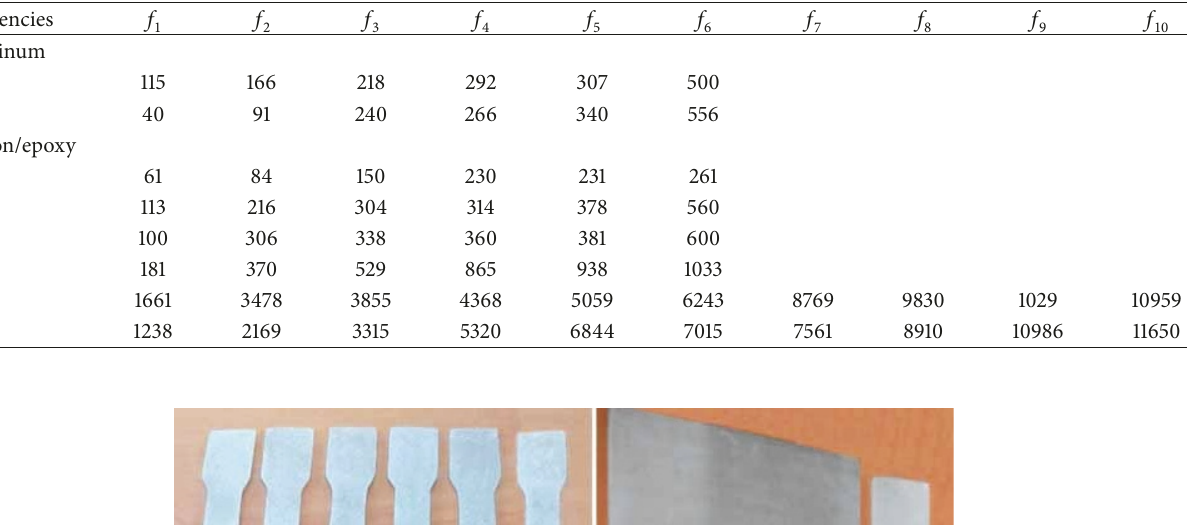
Table 5: Natural frequencies of the aluminum and carbon/epoxy plates obtained by ABAQUS solver.